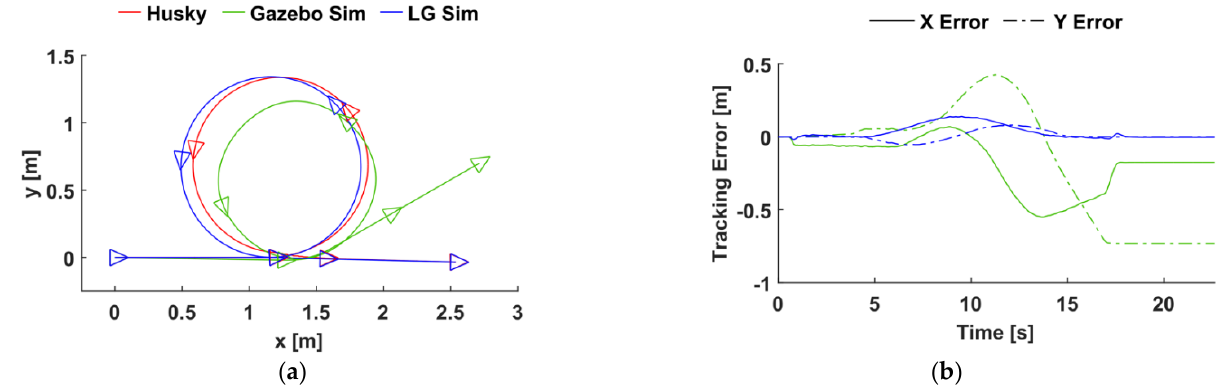
Figure 14. ( a ) Trajectory and ( b ) tracking error of the LG and Gazebo simulations and experimental data for the circle maneuver.